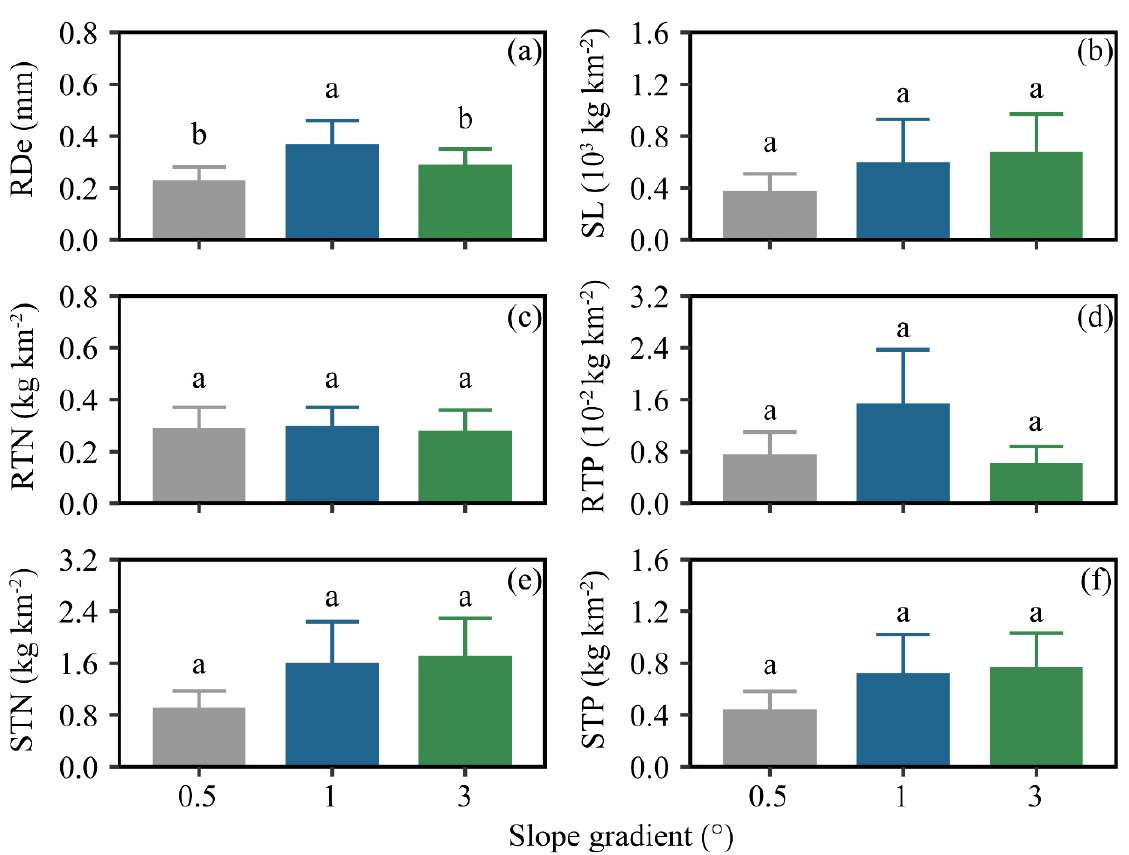
Figure 4. The ( a ) runoff depth (RDe), ( b ) soil loss (SL), ( c ) total nitrogen in runoff (RTN), ( d ) total phosphorus in runoff (RTP), ( e ) total nitrogen in soil loss (STN), and ( f ) total phosphorus in soil loss (STP) for slope gradients of 0.5°, 1°, and 3°. Values followed by different letters above a column are significantly different at p ≤ 0.05.